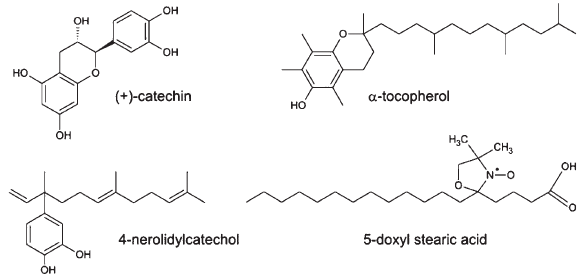
Figure 1. Structure of (++)-catechin, a -tocopherol, 4-nerolidylca- techol (4-NC), and the spin label 5-doxyl stearic acid